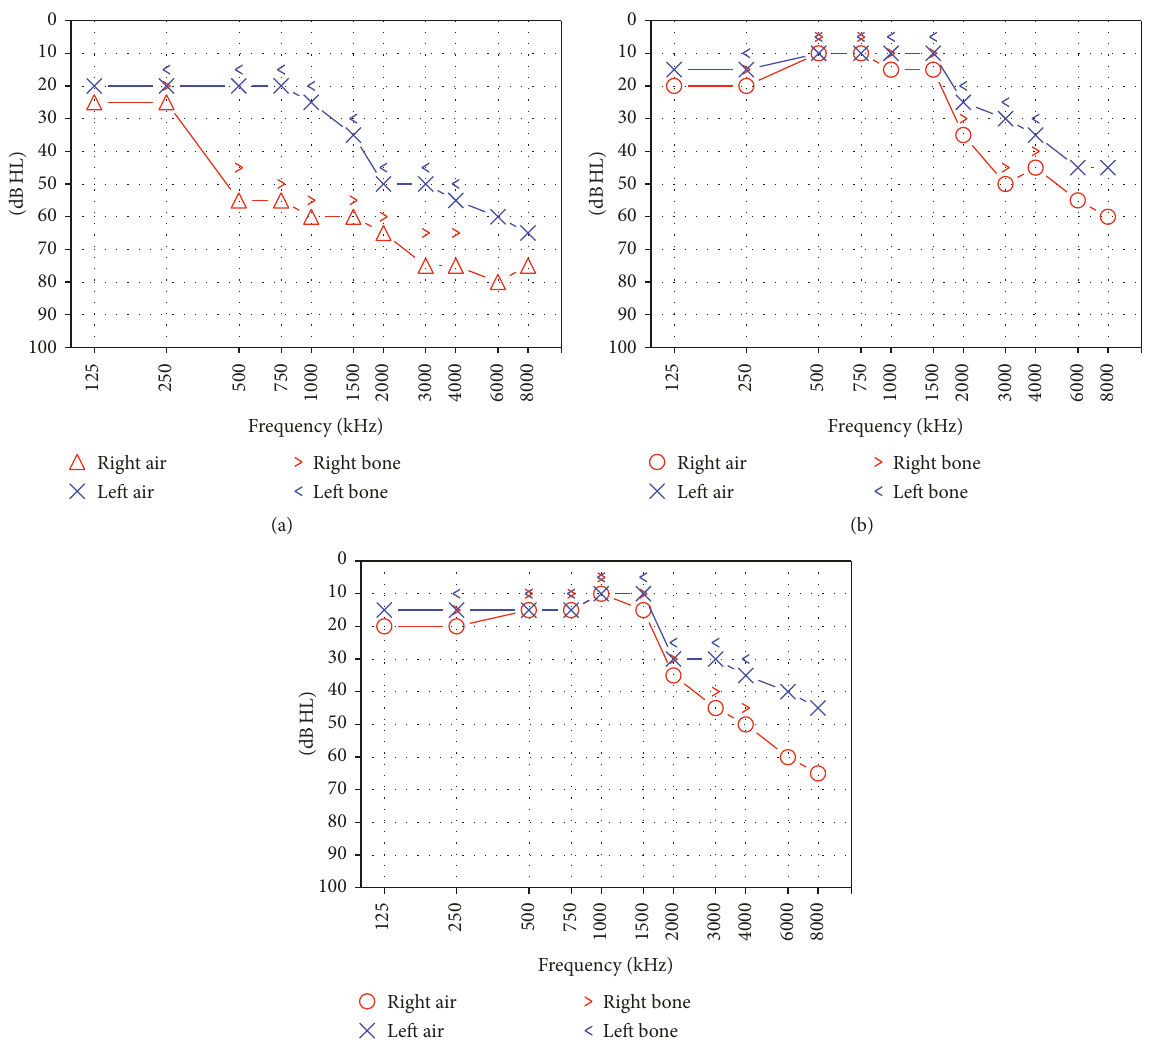
Figure 4: Pure Tone Audiometry recorded one, 14, and 60 days after onset of sudden hearing loss in the left ear (second episode). (a) Pure Tone Audiometry confirmed hearing loss in the left ear, with an average threshold of 38.18 dBHL; threshold in the right ear was unmodified compared to the exam performed 14 days after cessation of previous treatment (56.09dB HL); (b) Pure Tone Audiometry recorded 14 days afterhearinglossonsetshowedasignificantimprovementofhearinglossintheleftear(average:22.72 dB HL)butalsointherightear(average: 30.45 dB HL); (c) Audiometry 60 days after left sudden hearing loss onset showed no significant differences compared to previous exam, with preserved hearing threshold in both